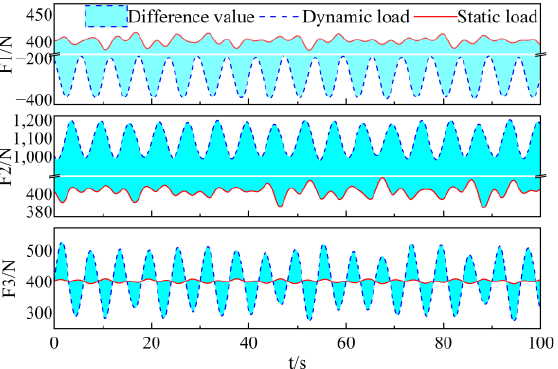
Figure 14. Tractive force of each drive support chain under static load or dynamic load.